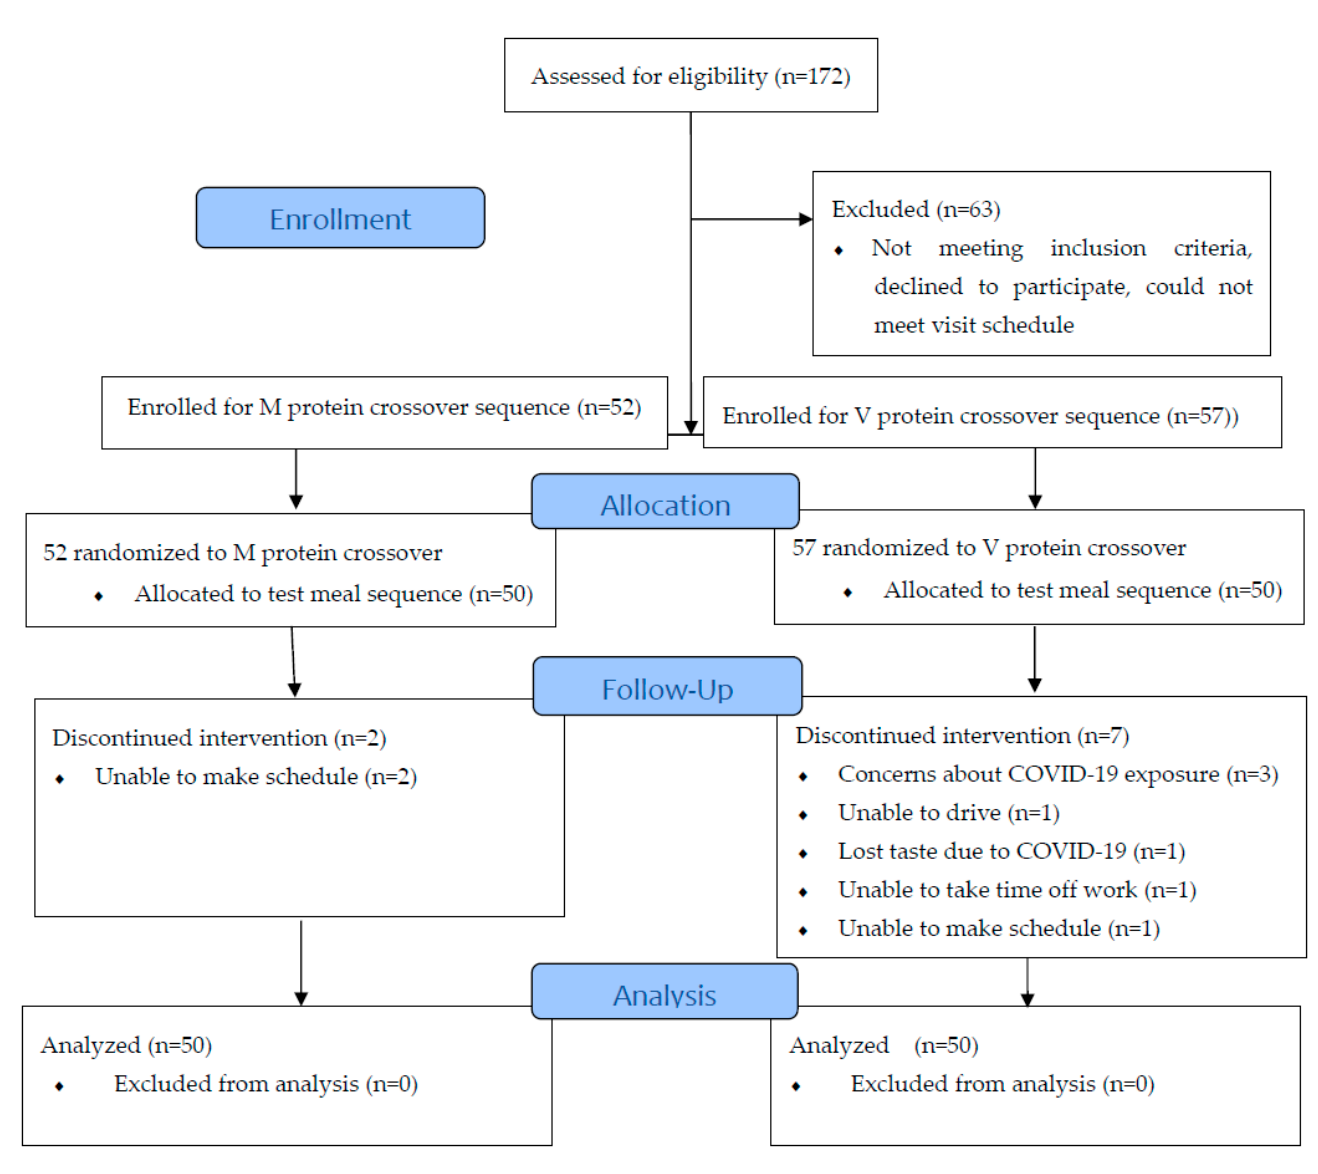
Figure 1. CONSORT Flow Diagram.